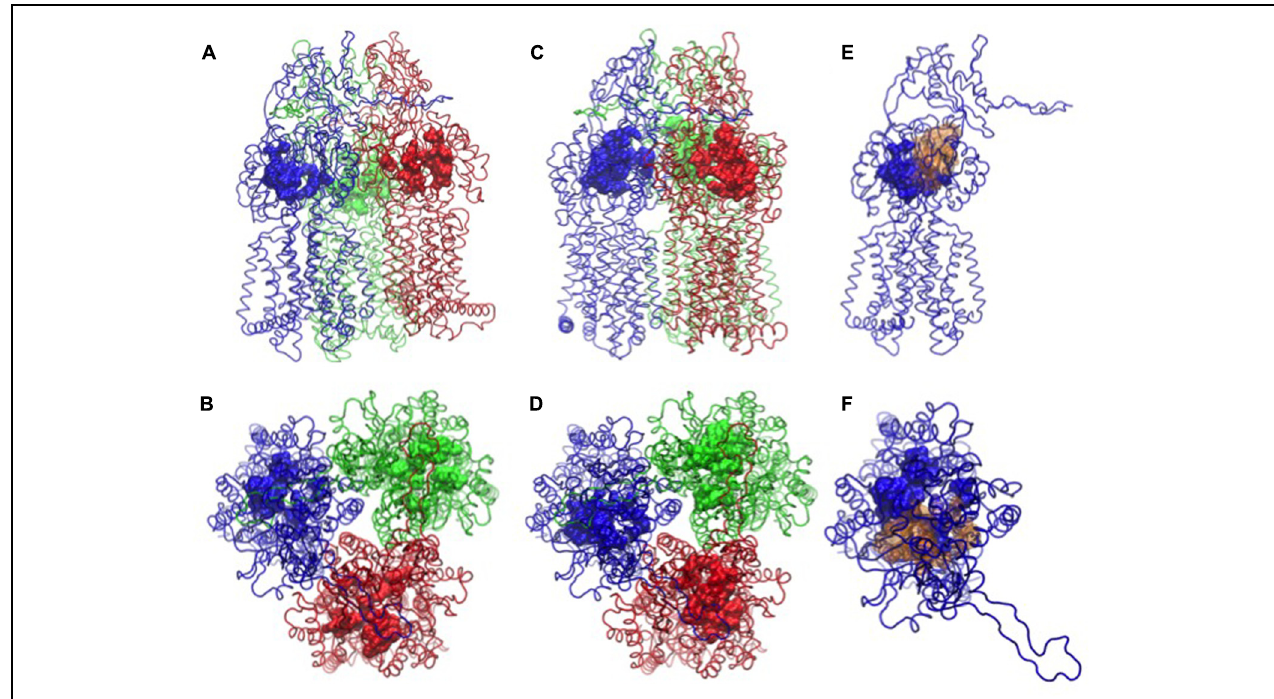
FIGURE 1 | Binding pockets of MexB [PDB code: 2V50 (Sennhauser et al., 2009)]. The monomers L, T, and O are in tube representation and colored in blue, red, and green, respectively. In (A,B) side and top views of MexB with the distal binding pocket depicted as surface, in (C,D) the access binding